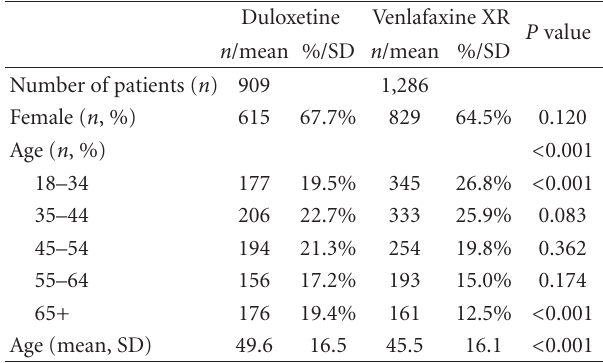
Table 1: Demographic characteristics of patients Initiating duloxe- tine or venlafaxine